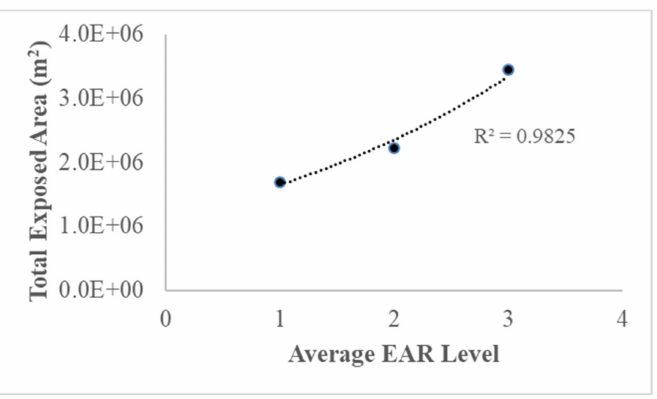
Figure 6. Regression line of total exposed area against the average